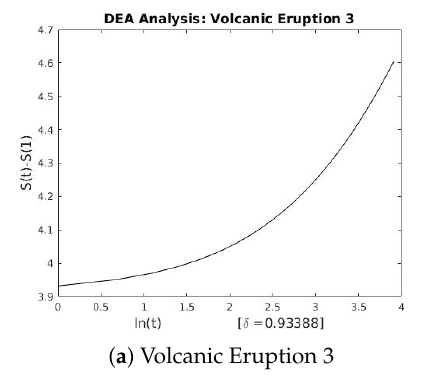
Figure A16. DEA for Volcanic Eruption 3 and 4.